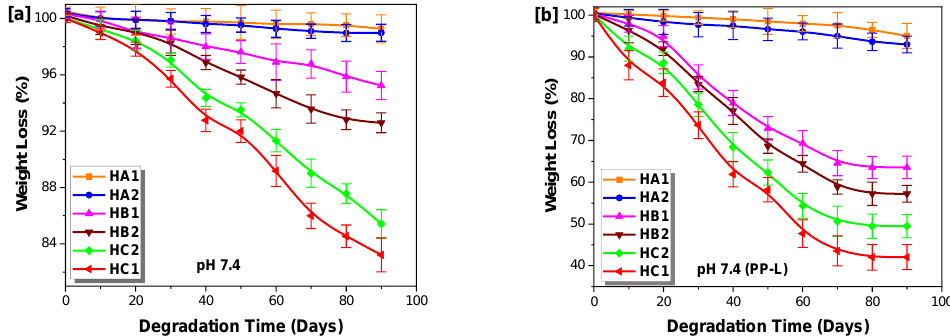
Figure 12. Residual weight loss vs. incubation time for poly(ether-ester)s under different conditions: ( a ) without PP-L, ( b ) with PP-L. ( a ) without PP-L, ( b ) with